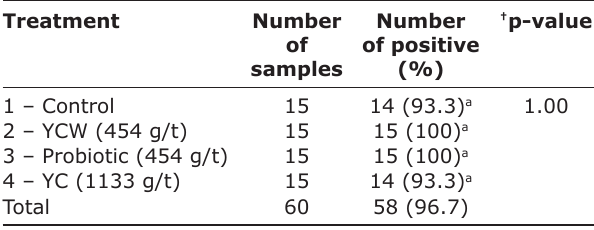
Table-1: Salmonella prevalence (%) in ceca samples by treatment group. Fifteen individually housed birds were sampled from each treatment group at 7 days post-challenge.